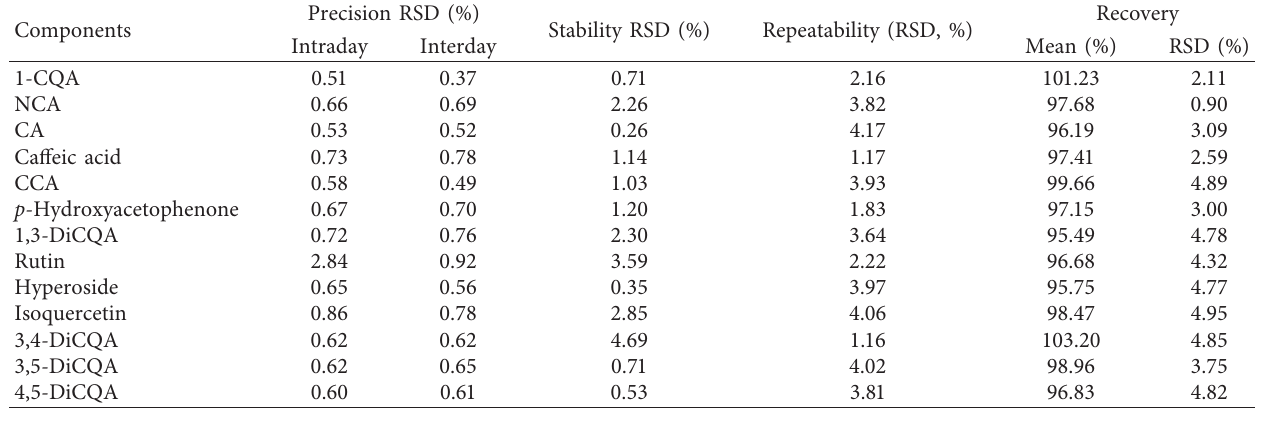
Table 3: Results of precision, stability, repeatability, and recovery tests ( n � 6).